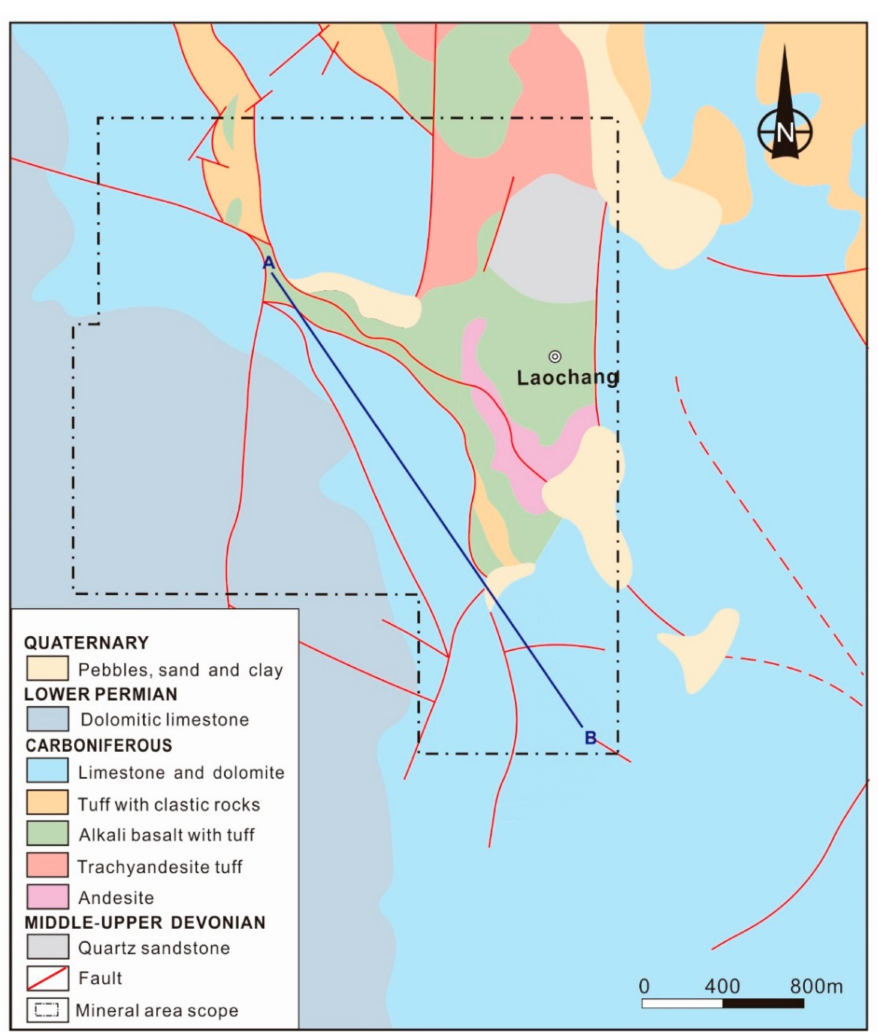
Figure 2. Geological map of the Laochang deposit (modified from Long